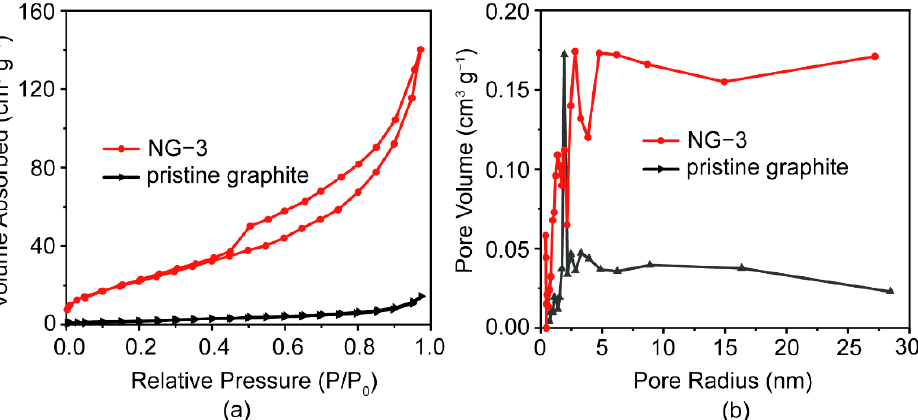
Figure 4. ( a ) The distribution plots of pore size and ( b ) isothermal N2 absorption for pristine graphite and NG-3